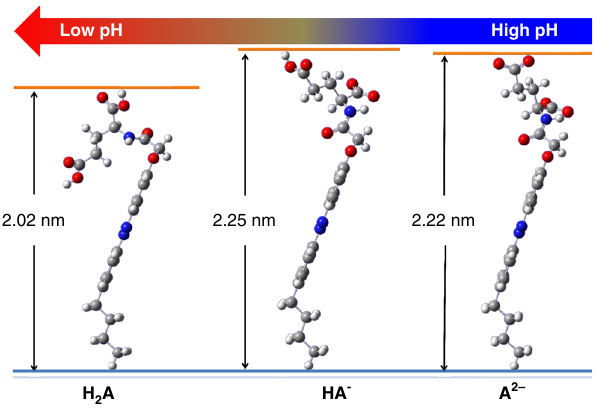
Fig. 5 DFT computation of L-3 amphiphile at different ionization states. Gaussian B3LYP/6-31 + G* optimization was utilized, the red, blue, dark gray, and light gray balls represent O, N, C, and H atoms, respectively. H 2 A represents L-3, while HA − and A 2 − are its ionized